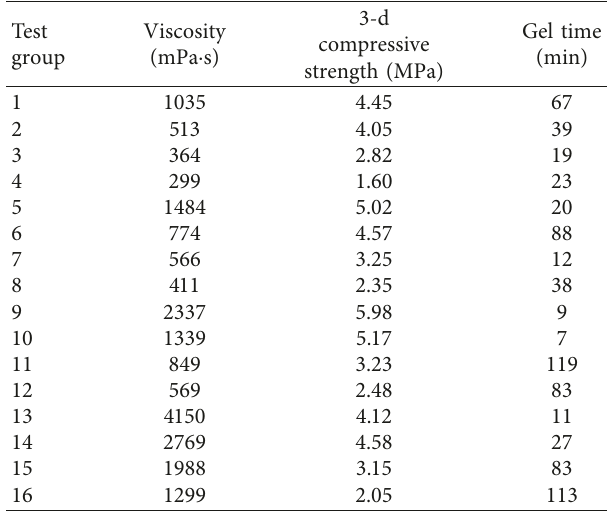
Table 3: Experimental results of orthogonal test.